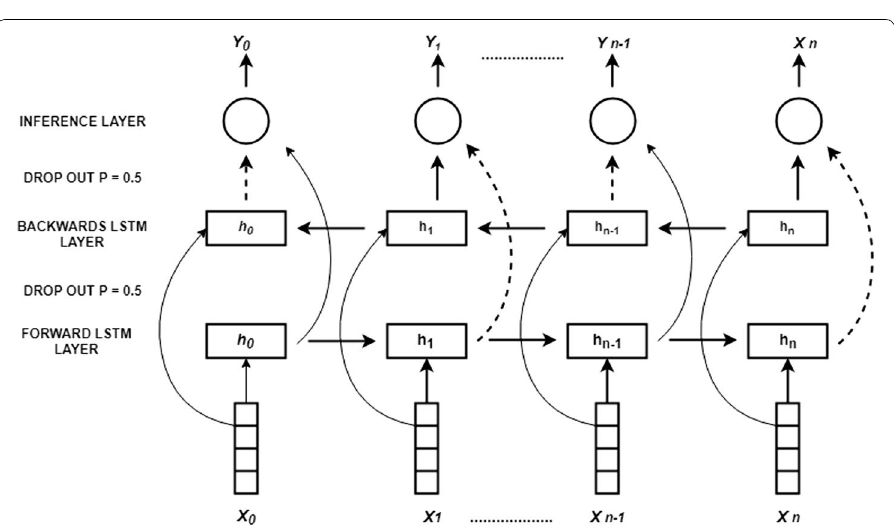
Fig. 9 Model architecture for recurrent neural